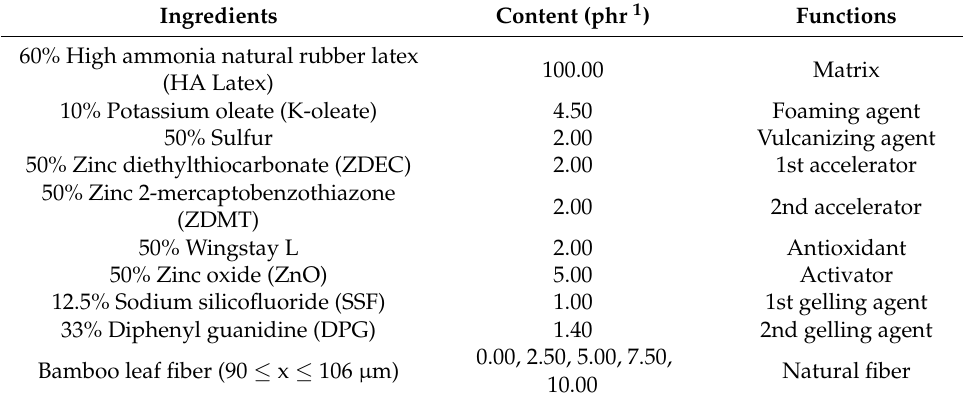
Table 1. Formulation of NRL foam composite at various BLF loadings.